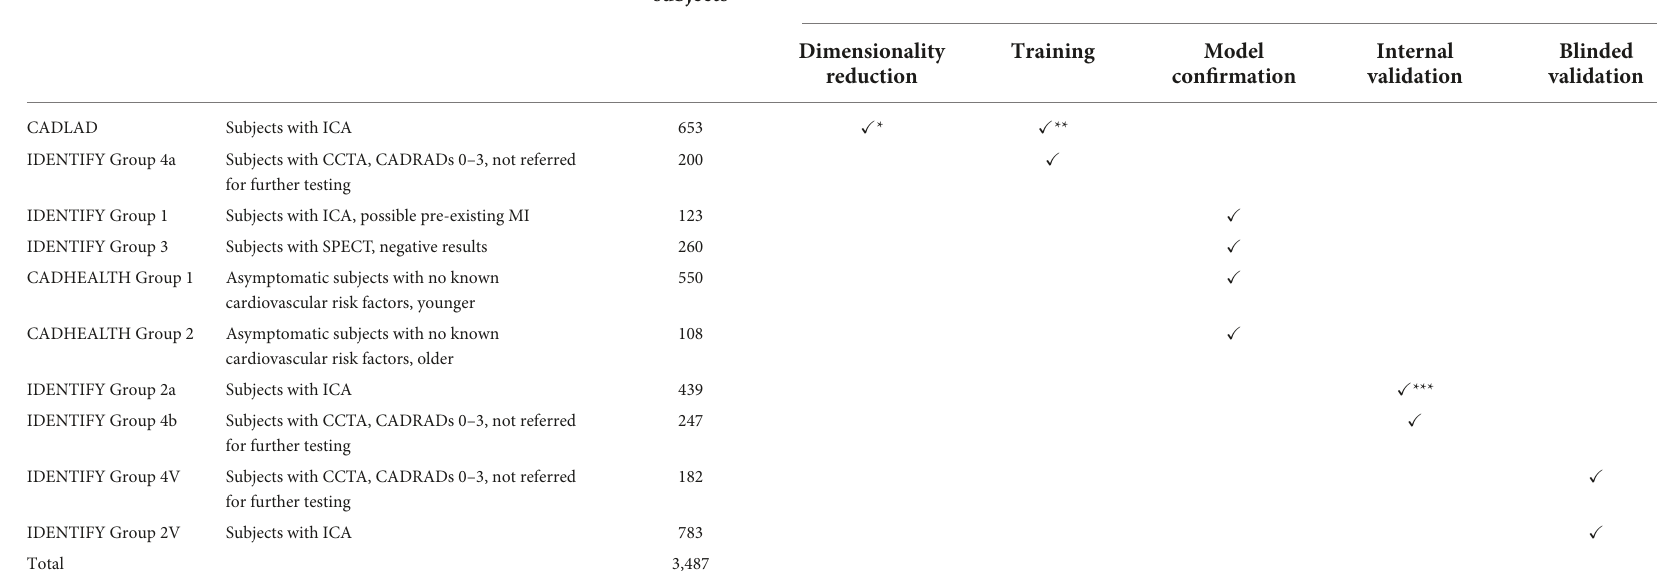
TABLE 1 Dataset